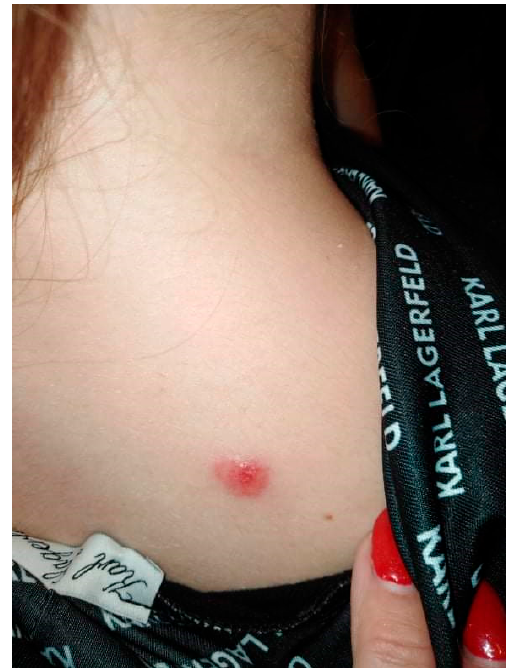
Figure 1. Erythematous papule on the right scapula. Over the next 3 months it gradually expanded and ulcerated with a thickened lump appearing in the centre (Figure 2) .